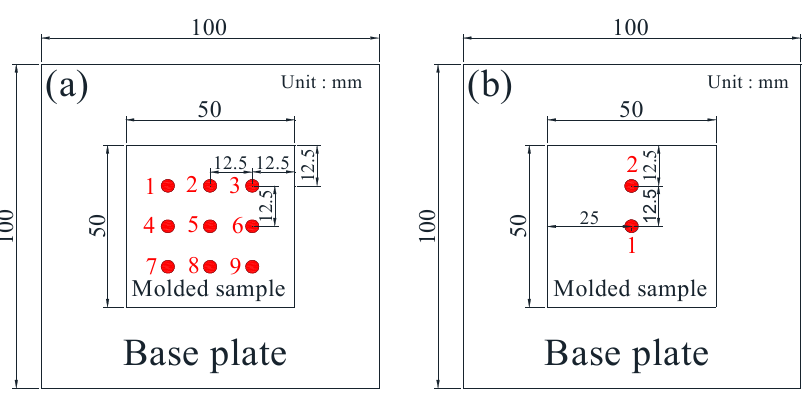
Figure 2. Schematic diagram of thermal fatigue equipment and sample size: ( a ) schematic diagram of thermal fatigue testing machine; ( b ) dimensions of thermal fatigue specimens.